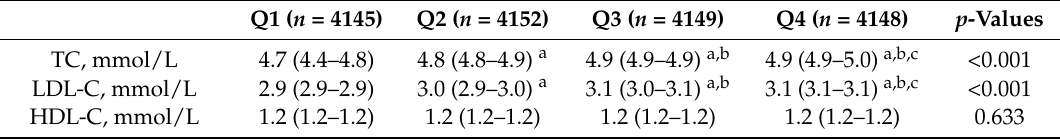
Table 4. Mean (95% CI) for dietary cholesterol intake by quartiles of individual serum cholesterol. Q1 ( n = 4145) Q2 ( n = 4152) Q3 ( n = 4149) Q4 ( n = 4148) p -Values